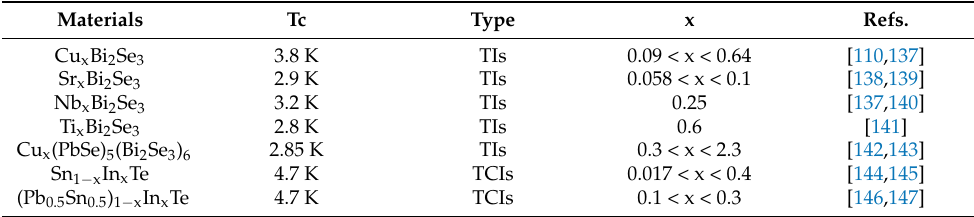
Table 4. List of typical Topological superconductor with different doping.